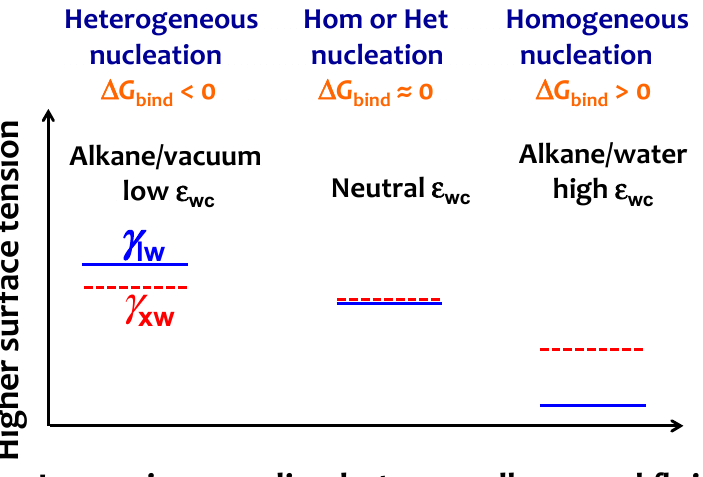
Figure 7. Scheme to interpret the change from heterogeneous to homogeneous nucleation mechanism on increasing the strength of alkane–solvent attraction ε wc . The simulation trends of Figure 5 indicate that on increasing ε wc the liquid alkane–water interfacial tension γ lw (blue line) decreases more than the crystalline alkane–water surface tension γ xw (red line), resulting in an increase of the binding free energy Δ G bind . The neutral ε wc signals the transition from heterogeneous to homogeneous at Δ G bind = 0, which coincides with the lack of preference for parallel or perpendicular orientation for the interfacial liquid alkane.